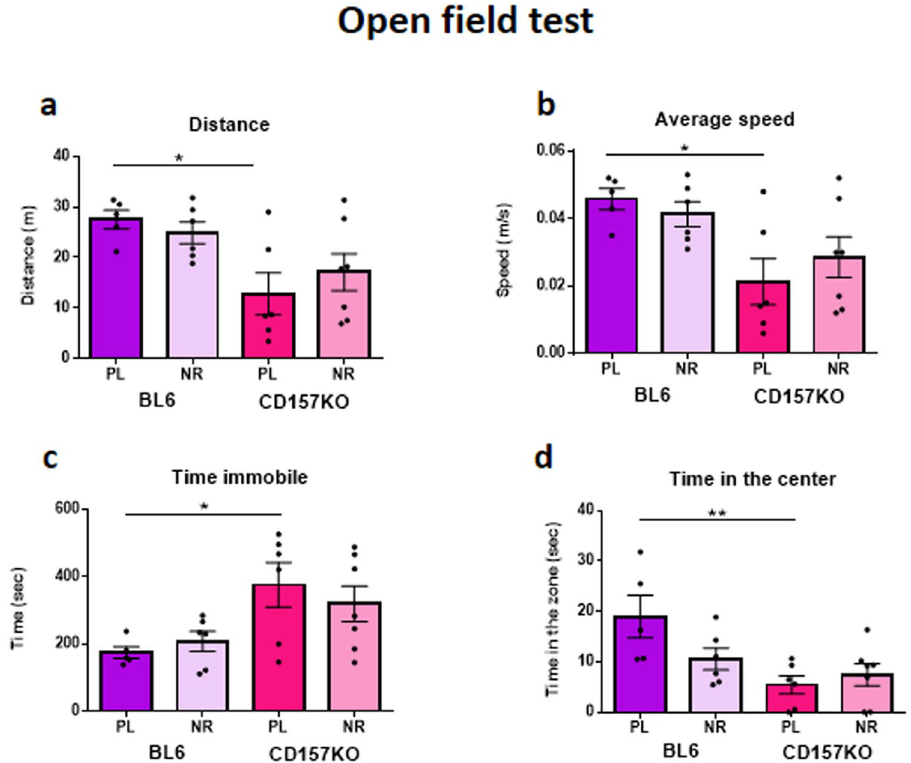
Figure 4. The behaviour of male mice for 10 min in the open field test. Daily gavage supplementation of nicotinamide riboside (NR, 3 mg/mouse) for 12 days induced no effect on any behavior by wild-type (BL6) nor the behavior deficits by CD157KO mice, compared with those of placebo treatment (PL). Two way ANOVA reveals significant effects only in the genotype: ( a ) distance traveled, F 1,20 = 11.71, P = 0.0027; ( b ) average speed, F 1,20 = 11.69, P = 0.0027; ( c ) time immobile, F 1,20 = 10.38, P = 0.0043; ( d ) time spent in the centre of the open field * P < 0.05, and ** P <